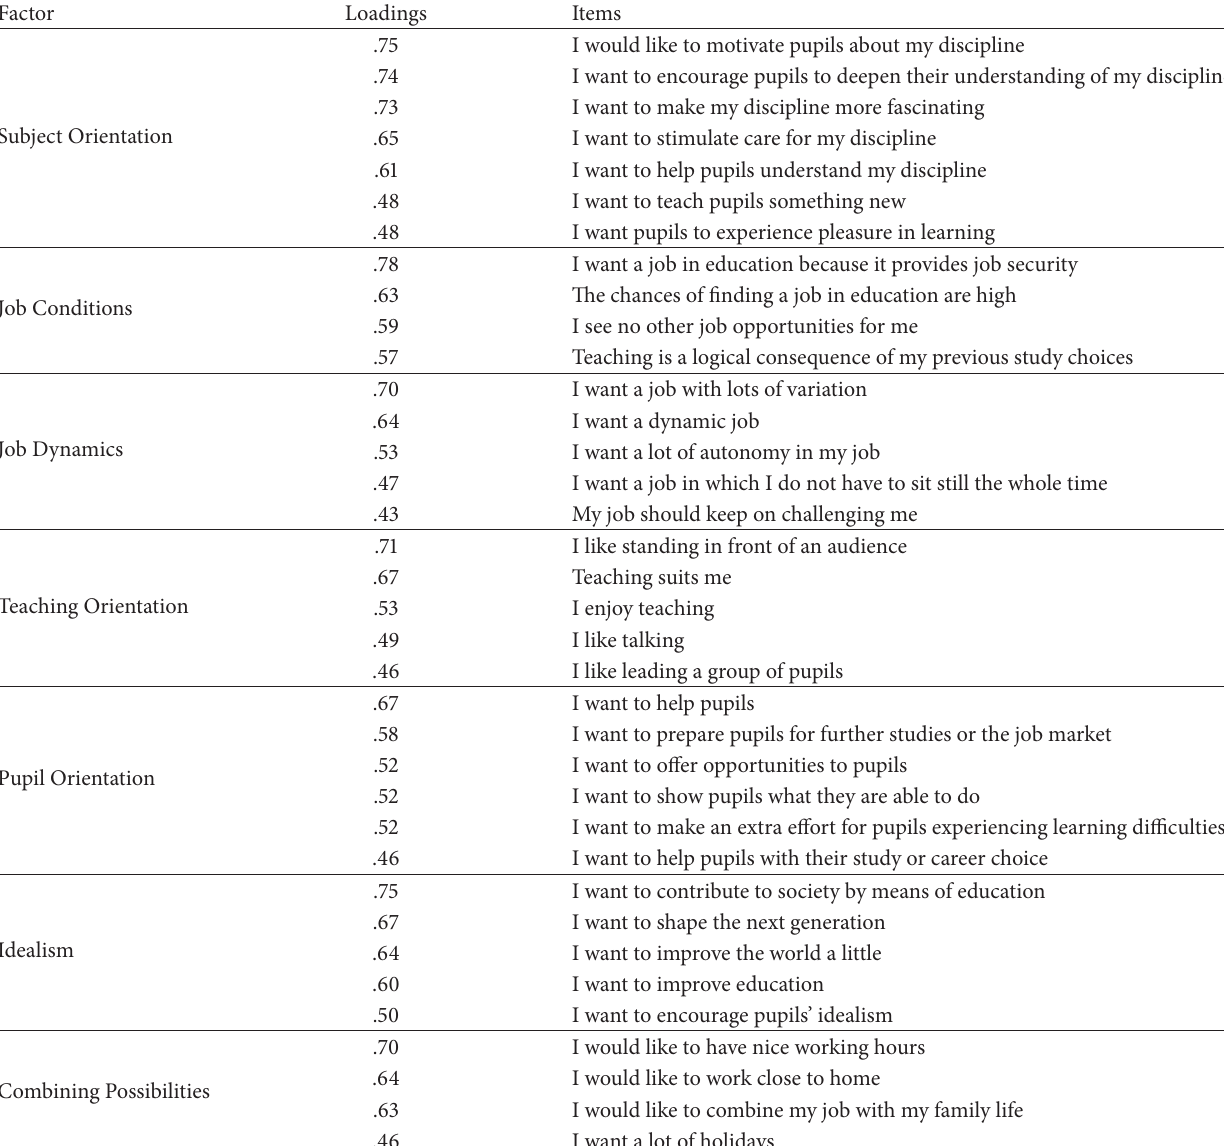
Table 2: Items and factor loadings based on the pattern matrix of the 7-factor